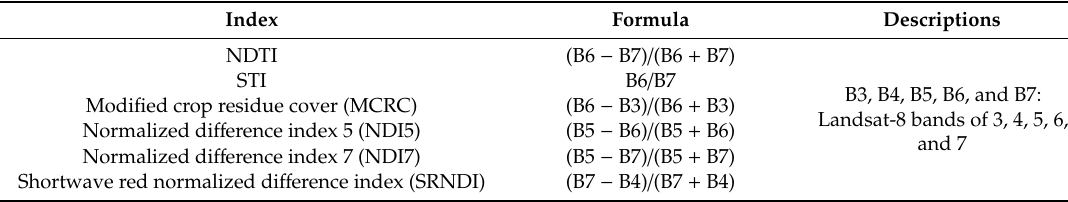
Table 2. Landsat-8-based tillage indices.